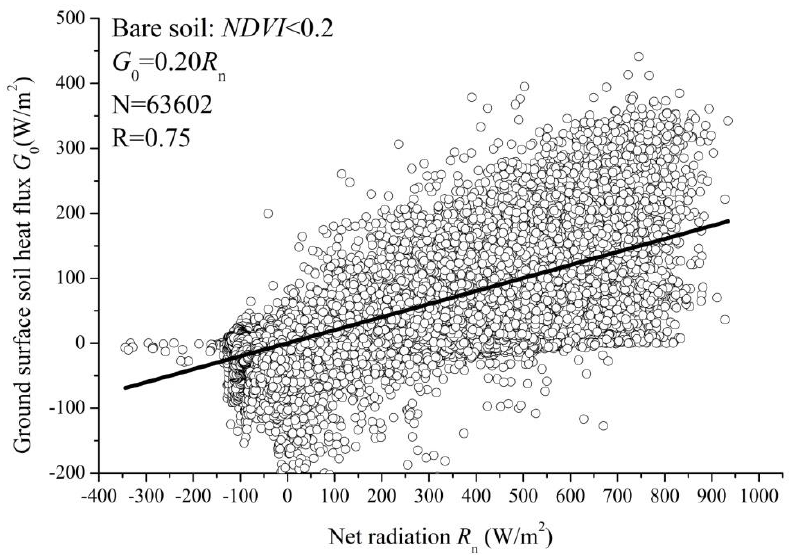
Figure A2. Adjustment scatter plot for the ratio Γ s of ground surface soil heat flux G 0 to net radiation R n in bare soil on the TP ( R , the correlation coefficient; N, the number of samples.).